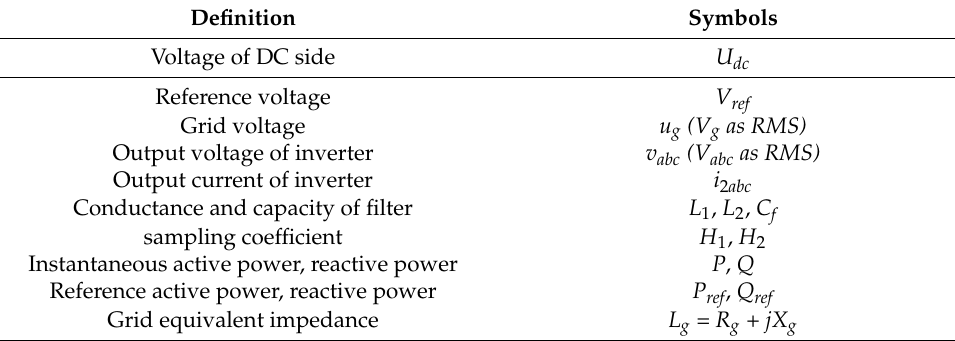
Table A1. Definition of symbols in Figure